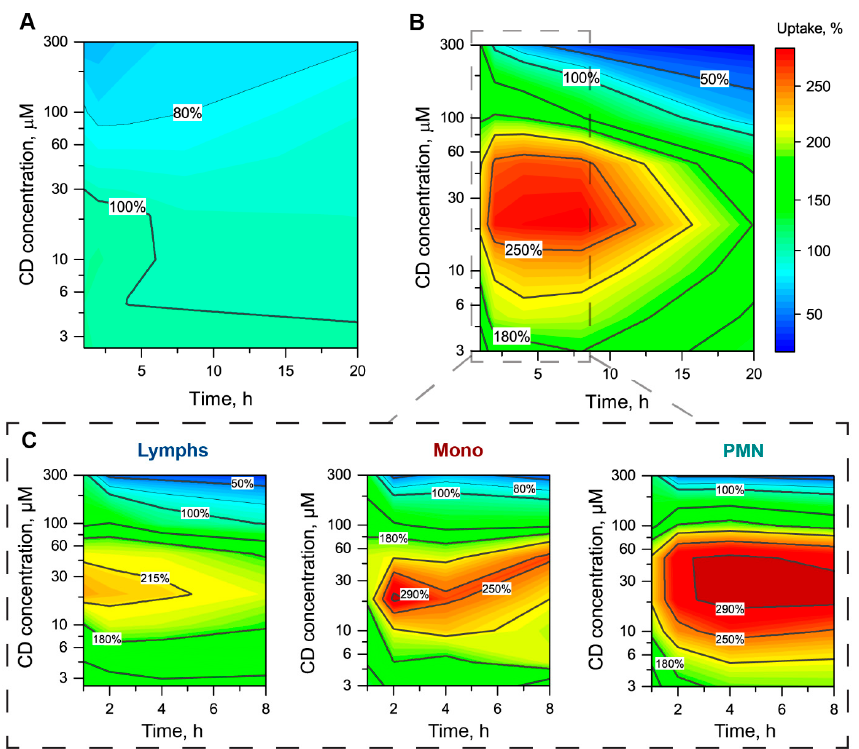
Figure 5. Alteration of mTHPC uptake in different populations of blood cells in the presence of Me- β -CD. The 2D contour plots of mTHPC uptake in ( A ) RBC, ( B ) WBC, and ( C ) particular WBC populations (Lymps, Mono, PMN) as the function of time and concentration of Me- β -CD. Uptake of mTHPC in the absence of Me- β -CD was taken as 100%. The concentration of mTHPC was 4.5 µM.